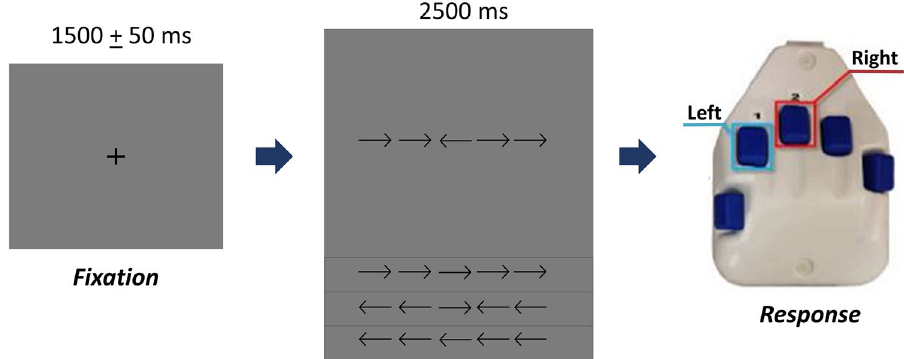
Figure 1. The Eriksen Flanker task paradigm. For each trial, the adolescents fixated on a crosshair for 1500 + 50 ms, then a display with a series of five arrows appeared for 2500 ms. The adolescents responded with their right hand regarding the direction of the center arrow (left: 2nd digit, right: 3rd digit). In the congruent condition, the flanking arrows pointed in the same direction as the middle arrow, whereas in the incongruent condition the flanking arrows pointed in the opposite